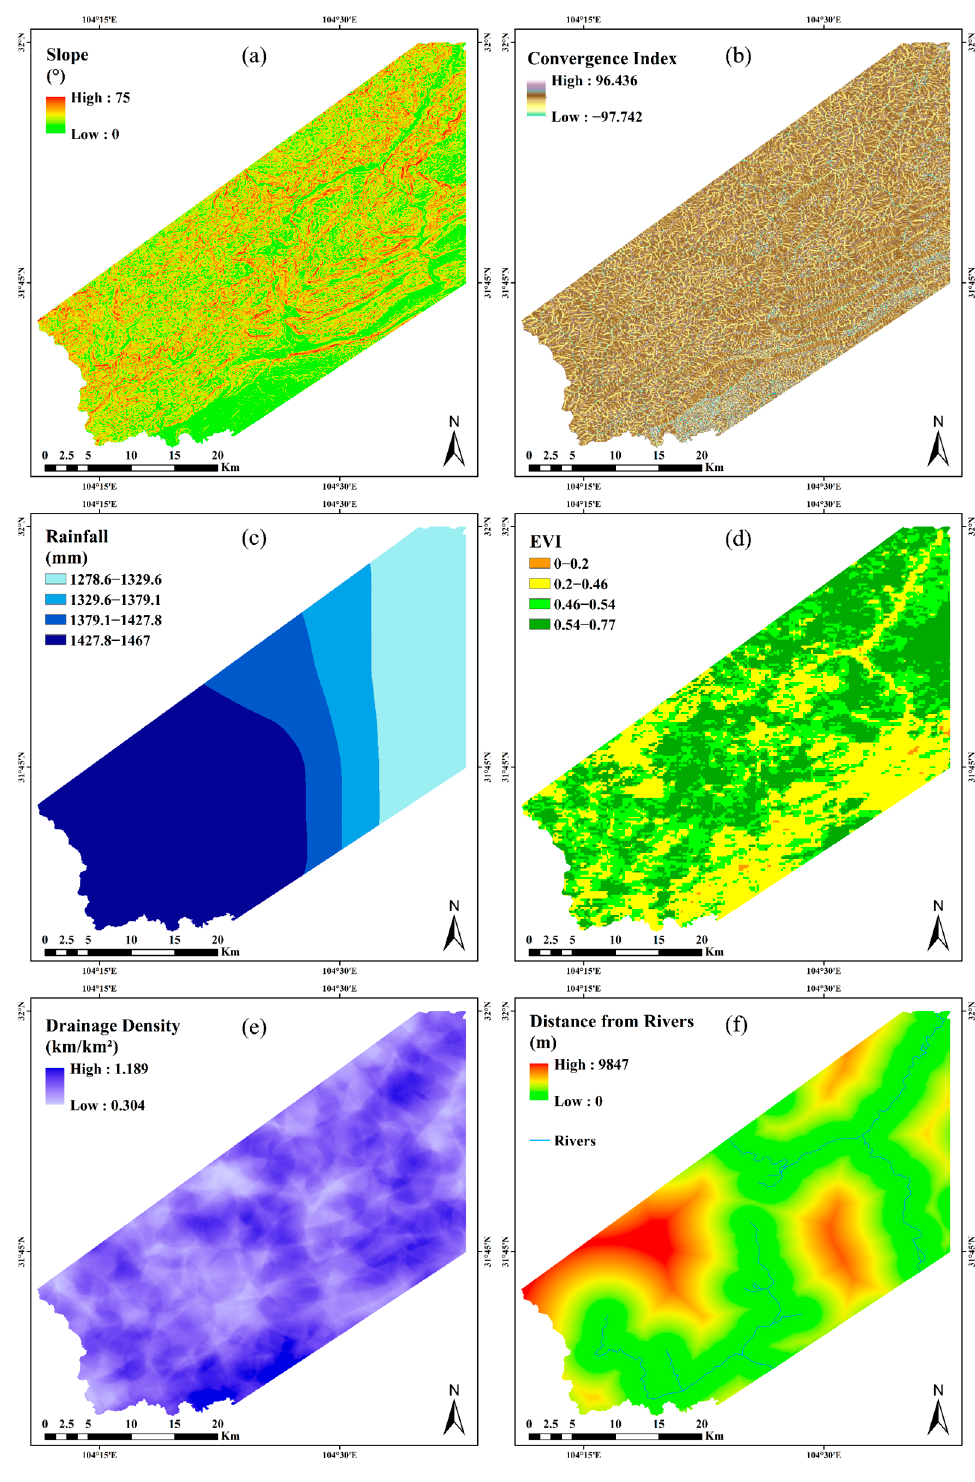
Figure 4. The spatial database constructed for groundwater potential I: ( a ) slope, ( b ) convergence index, ( c ) rainfall, ( d ) EVI, ( e ) drainage density, ( f ) distance from rivers.